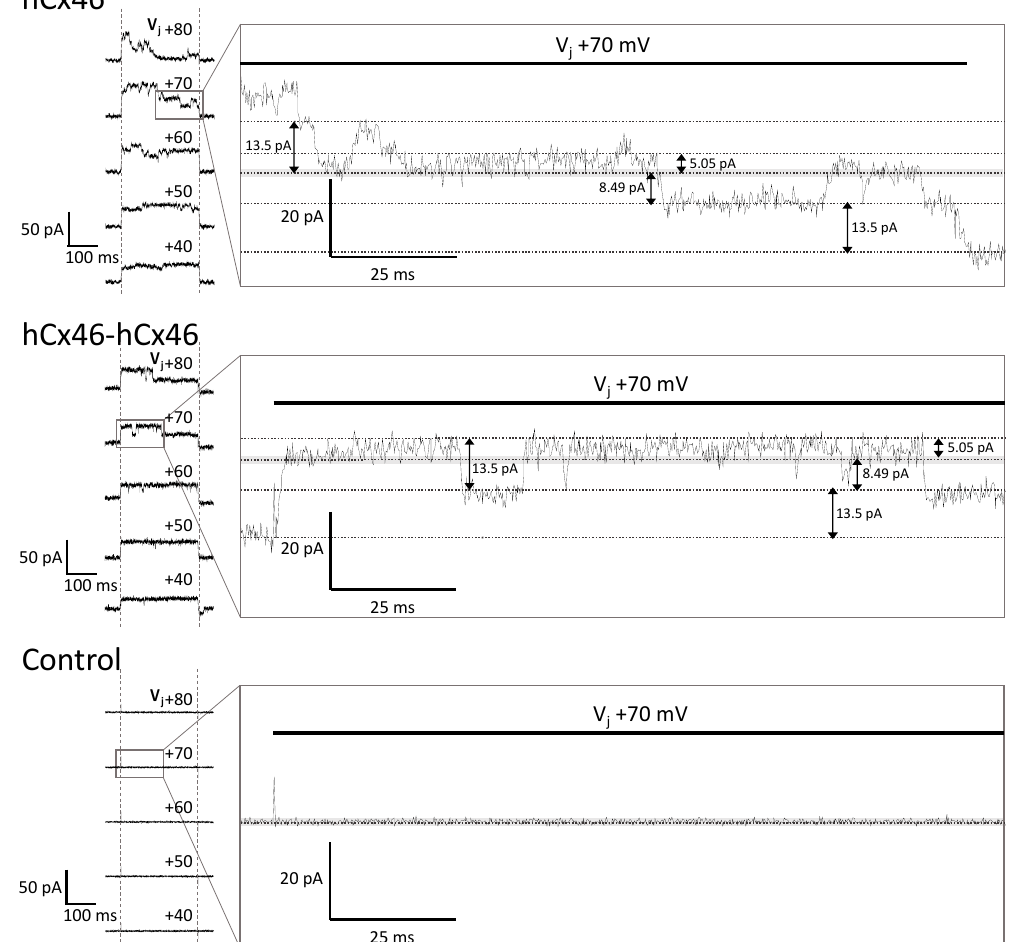
Figure 6. Recordings of dual whole-cell patch-clamp experiments. N2A cells were cultured and transfected with the different IRES-GFP-plasmids. As control, cells expressing only soluble GFP in the cytosol were used. Twenty-four hours post transfection, the dual whole-cell patch-clamp experiments were performed. The resting membrane potential was set to − 40 mV for both cells. One cell of a cell pair was alternatingly stepped from − 120 mV to +60 mV, while the junctional currents were recorded in the other cell. The junctional currents ( Δ I2) recorded during the 250 ms-long voltage pulses at different transjunctional potentials are shown above the current responses. Magnification of the Vj +70 mV traces of the hCx46 monomer, as well as of the hCx46-hCx46 homodimer, showed several simultaneously open channels, with a large conductance of ~193 pS (13.5 pA step), and low conductance of ~72 pS (5.05 pA step) and ~121 pS (8.49 pA step). Similar steps were observed for Cx46 by other authors [38–41]. The control cells showed only the background noise, which was below 2 pA (grey band), indicating that the fluctuations of about 5 pA were conducting substates. Table 3. Large conductance states of the gap junction channels expressed in transfected N2A cell pairs. n gives the number of analyzed cell pairs for each variant.